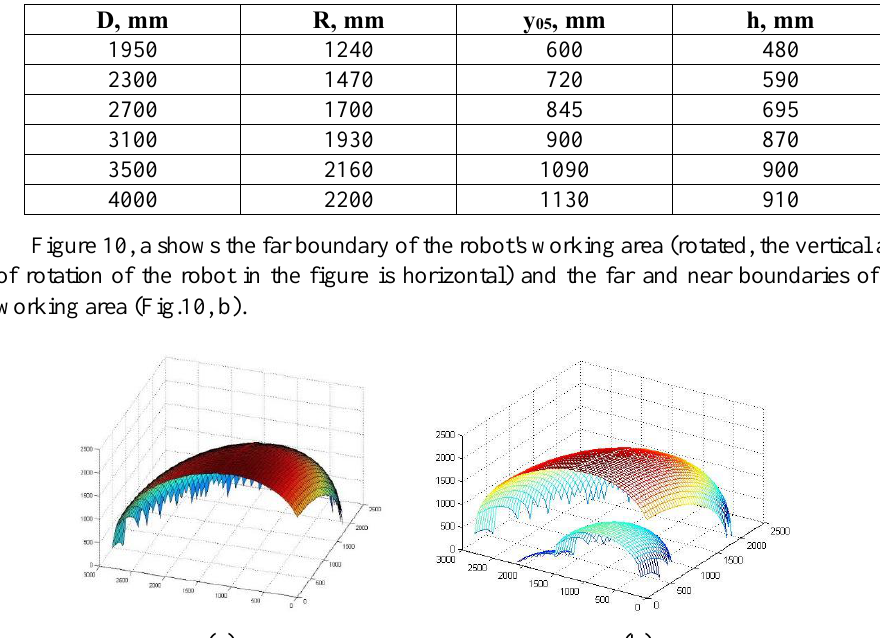
Table 1. The size of the bottoms with a petal division.